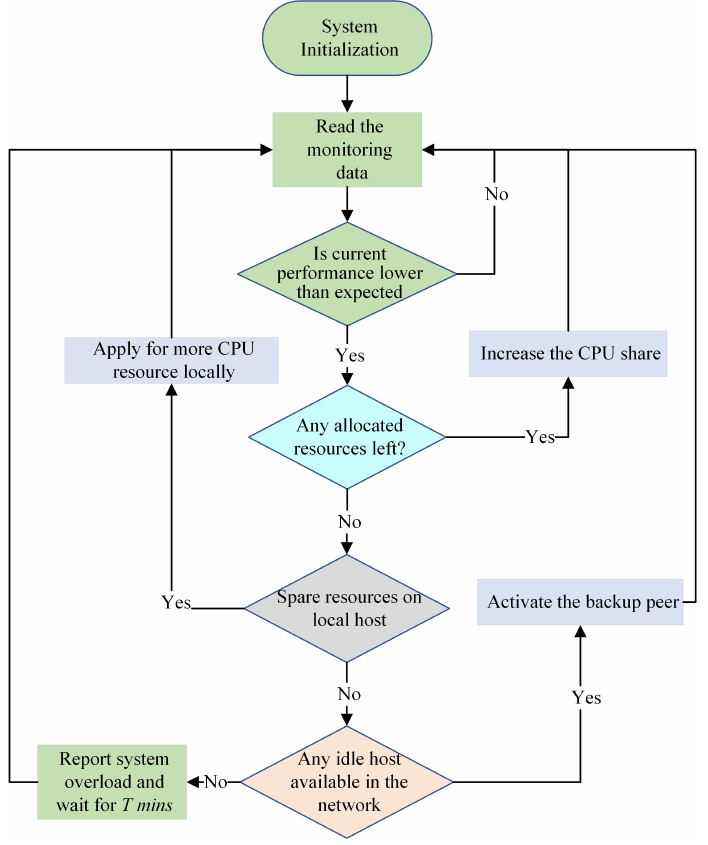
Figure 3. Flowchart of the proposed